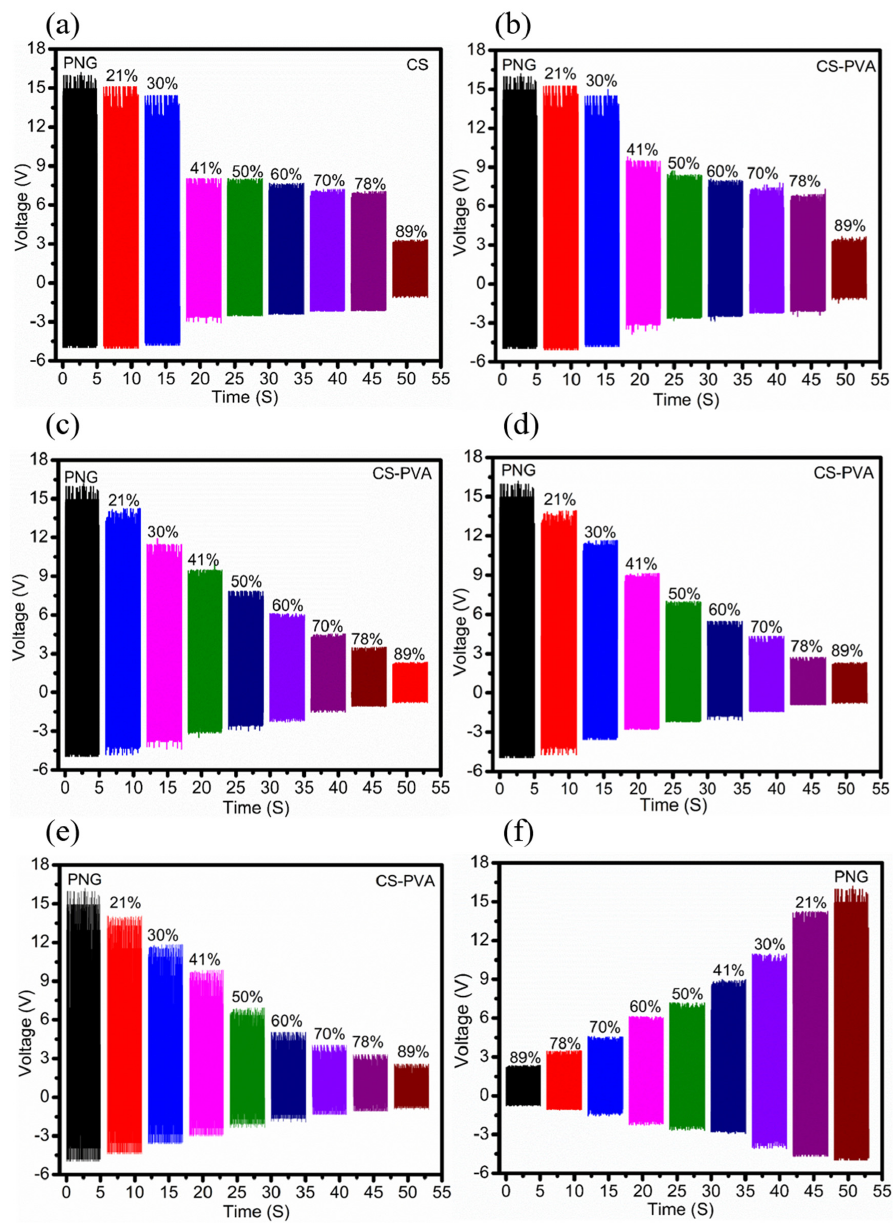
Figure 8. Voltage response of CS ‐ and CS ‐ PVA ‐ based humidity sensors when increasing relative humidity from 21% to 89% RH under a mechanical force of 10 N. ( a ) CS ‐ based HS, ( b ) 90/10 (CS ‐ PVA) HS, ( c ) 70/30 (CS ‐ PVA) HS, ( d ) 50/50 (CS ‐ PVA) HS, ( e ) 40/60 (CS ‐ PVA) HS, and ( f ) voltage response of the (70/30) CS ‐ PVA ‐ based humidity sensor when the relative humidity varied from 89% to 21% RH. The sensing mechanism of the CS ‐ PVA ‐ based humidity sensors with different vol ‐ ume ratios (90/10, 70/30, 50/50 and 40/60) of CS ‐ PVA were tested with different ranges of